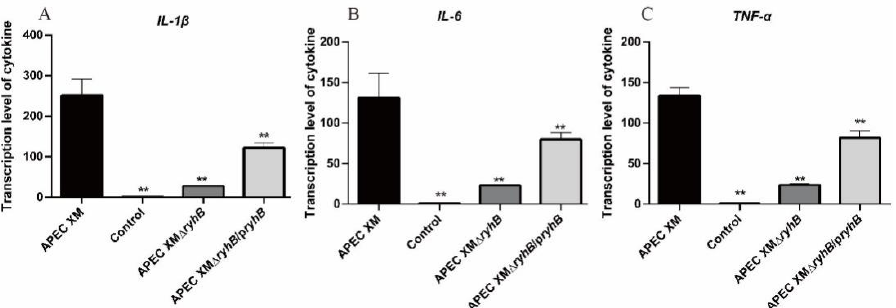
Figure 11. The mRNA transcript levels of the inflammatory cytokines IL-1 β ( A ), IL-6 ( B ) and TNF- α ( C ) were determined using qRT-PCR. GAPDH was used as the normalizing internal standard. The results were analyzed with one-way ANOVA and are presented as the means ± standard errors of the mean for three independent experiments. Significant differences between the APEC XM and other groups are indicated (**, p < 0.01).